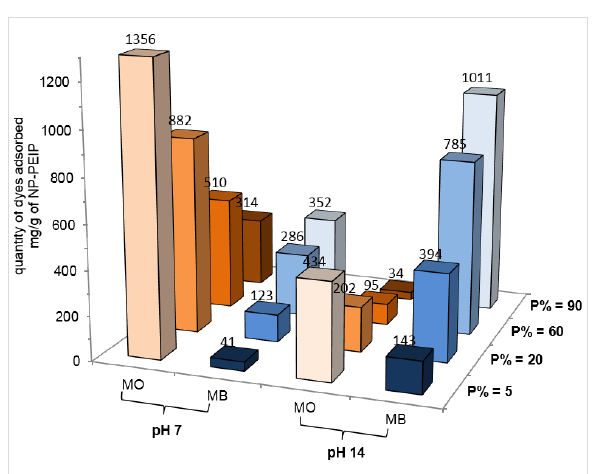
Figure 4: Removed amounts of MO and MB dyes by NP-PEIP x at pH 7 and 14. P% significantly affects adsorption of MB and MO. At neutral pH, much more MO is eliminated than MB, while the contrary is ob- served at basic pH.